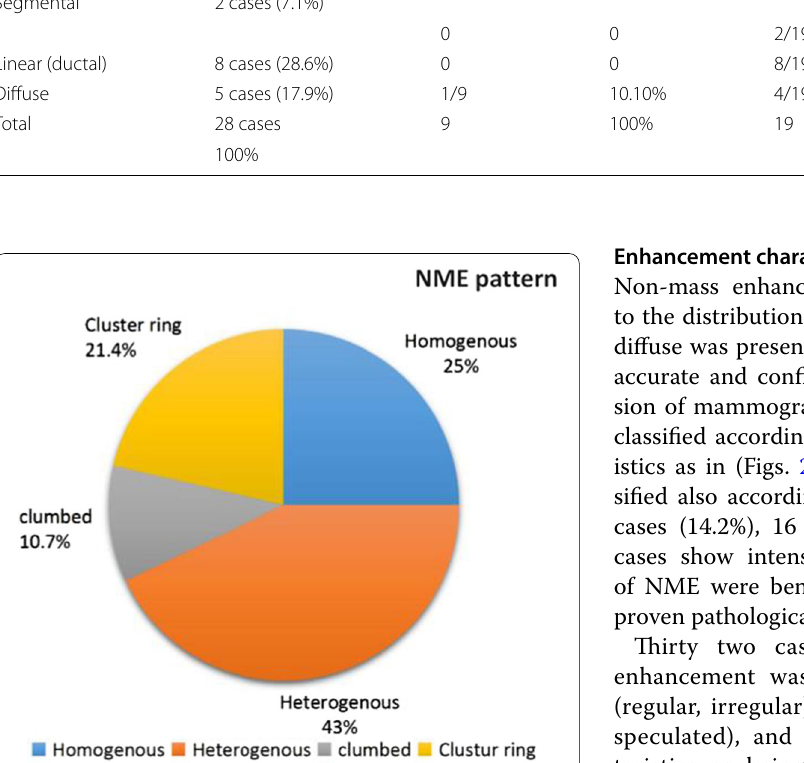
Fig. 2 Non mass enhancement pattern (NME) by CEDM